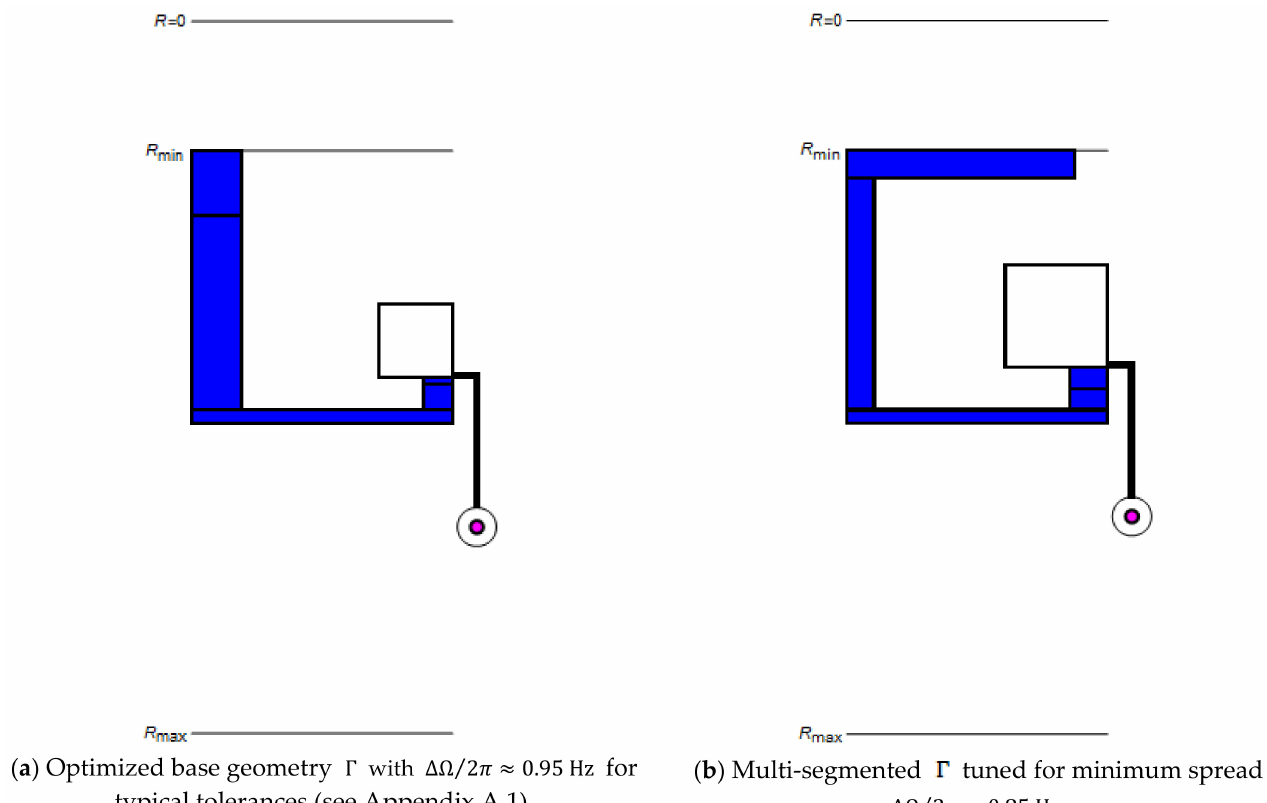
Figure 3. Comparison between structures Γ in their ( a ) basic and ( b ) multi-segmented versions for typical tolerances { ∆ γ k } (see Appendix A.1) at identical radial position R = 3 cm and release rate Ω /2 π = 25 Hz after optimization of ∆Ω . Most notably, Γ in ( b ) displays a wider inner radial section of the reservoir and overall increased width of the inbound segment to “pin” the menisci at r 0 and r = R crest , and thus r ∆ r , to counter variation in Ω (5) and (6) via r ∆ r